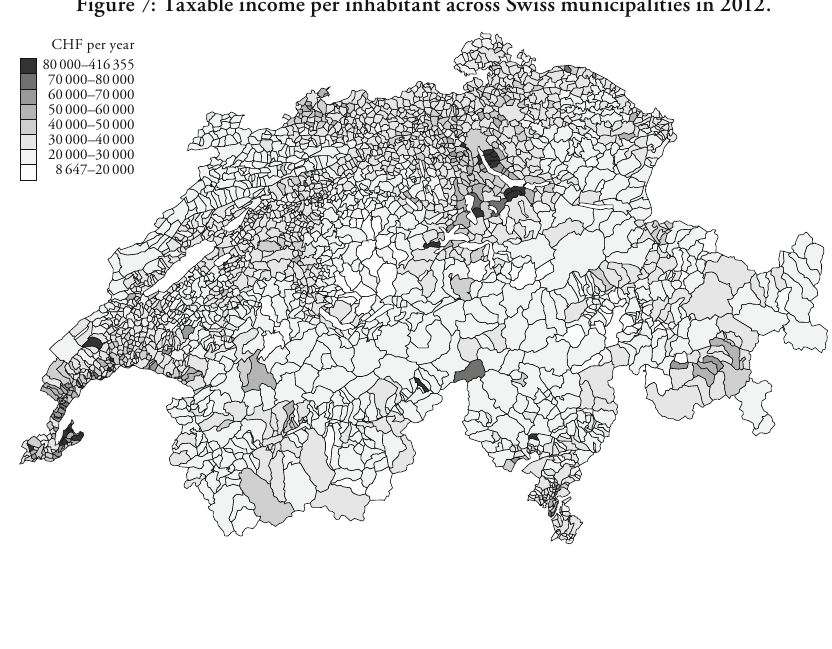
Figure 7: Taxable income per inhabitant across Swiss municipalities in